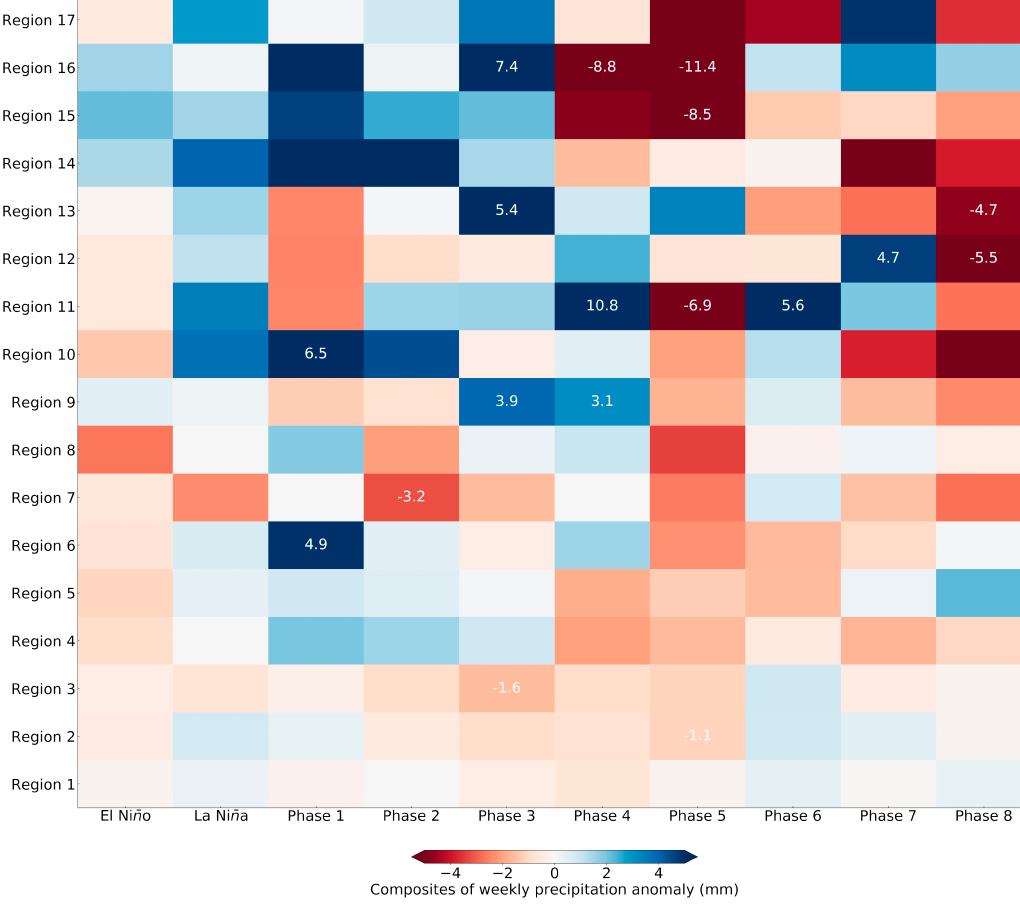
Figure 13. Composites of weekly precipitation anomalies (mm) in each of the ENSO and MJO phases during the boreal summer monsoon. Statistical significance at the 5% level is labelled.